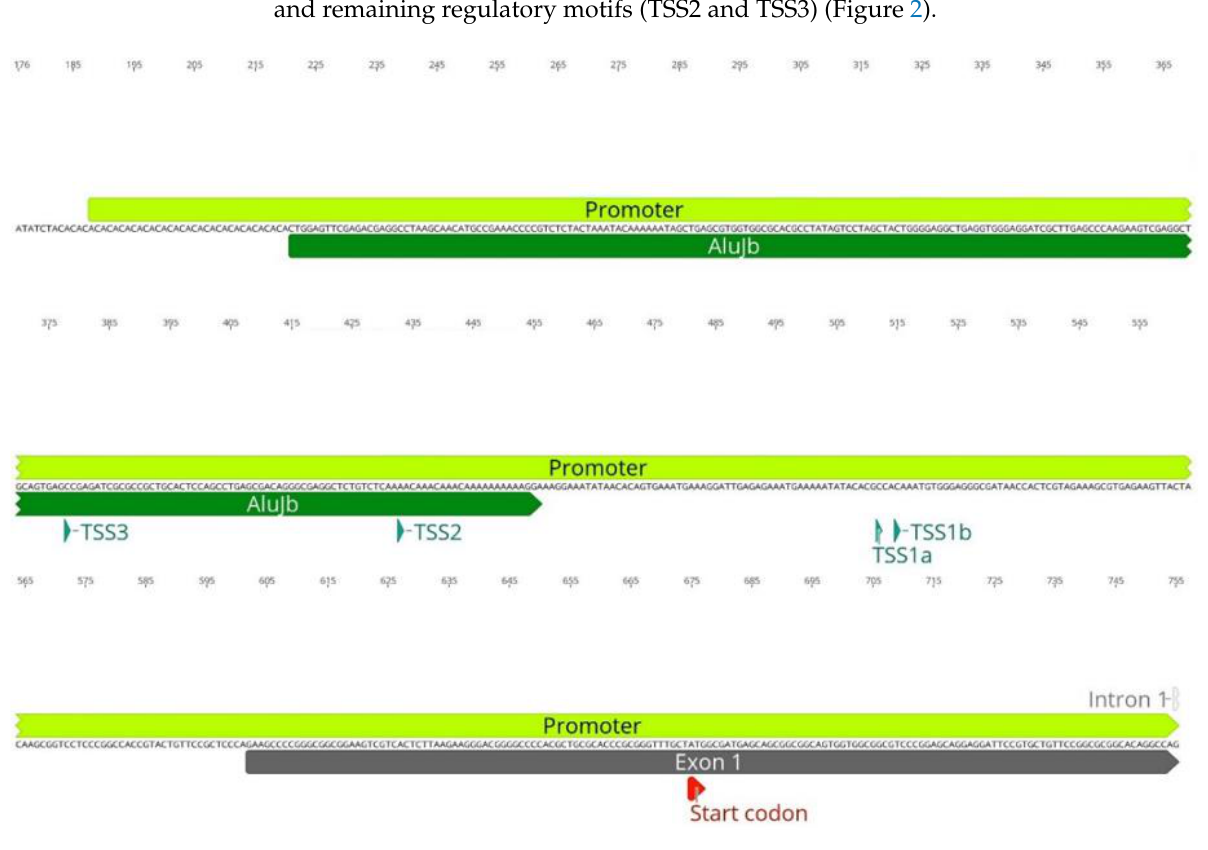
Figure 1. AluJb element within the SMN1 / 2 promoter region. An AluJb element (represented by a dark green arrow) is inserted inside the promoter region of SMN1 / 2 , upstream of the canonical tran- scriptional start site (TSS1a). Transcriptional start sites (TSS), two of them located inside the AluJb sequence, and the start codon are represented by green and red arrowheads, respectively.